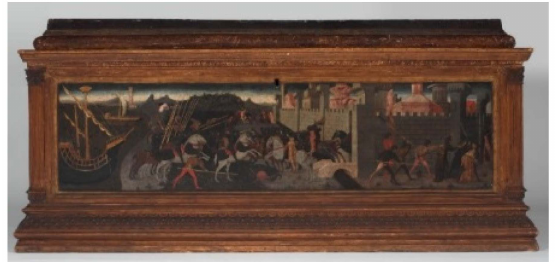
Figure 2. Paolo Uccello. Teseida: Battle of Teseo and the Amazons . c.1460. New Haven: Yale University Art Gallery. [15].